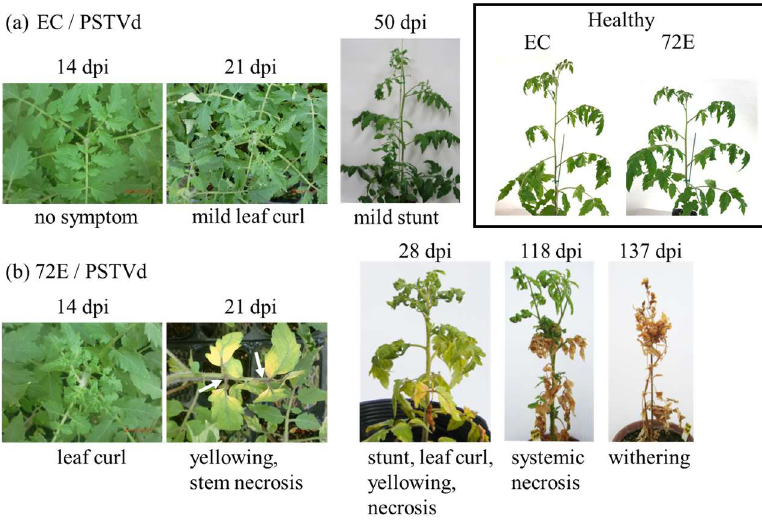
Figure 2. Lethal necrotic symptoms associated with potato spindle tuber viroid (PSTVd) infection in the DCL2 / 4i-72E ‘Moneymaker’ tomato line. The upper row ( a ) indicates line EC infected with PSTVd. Plants showed mild leaf curling ~21 dpi and mild stunting at 50 dpi. The lower row ( b ) indicates line 72E infected with PSTVd. Infected plants started to show yellowing and stem necrosis around 3–4 weeks after inoculation, then showed severe systemic necrosis around 2–3 months post inoculation, and finally stopped growing and died. Plants in the box are healthy lines 72E and EC (~50 dpi). Three replicates of plants showed similar symptoms. Photos were taken on the days indicated above the pictures.